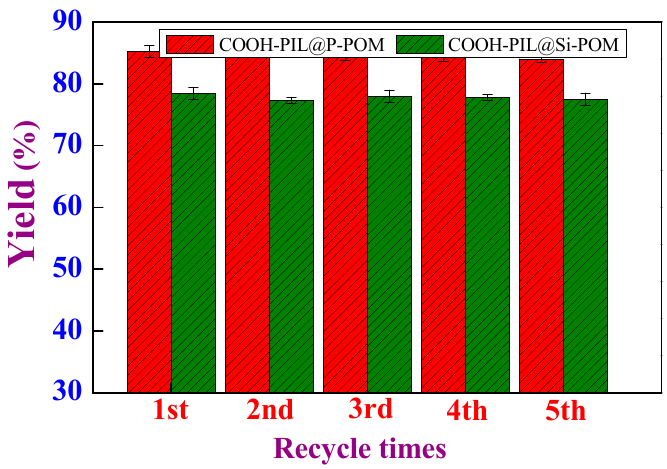
Figure 5. Reusability of COOH-PIL@P-POM and COOH-PIL@Si-POM in BV oxidation of cyclopentanone.